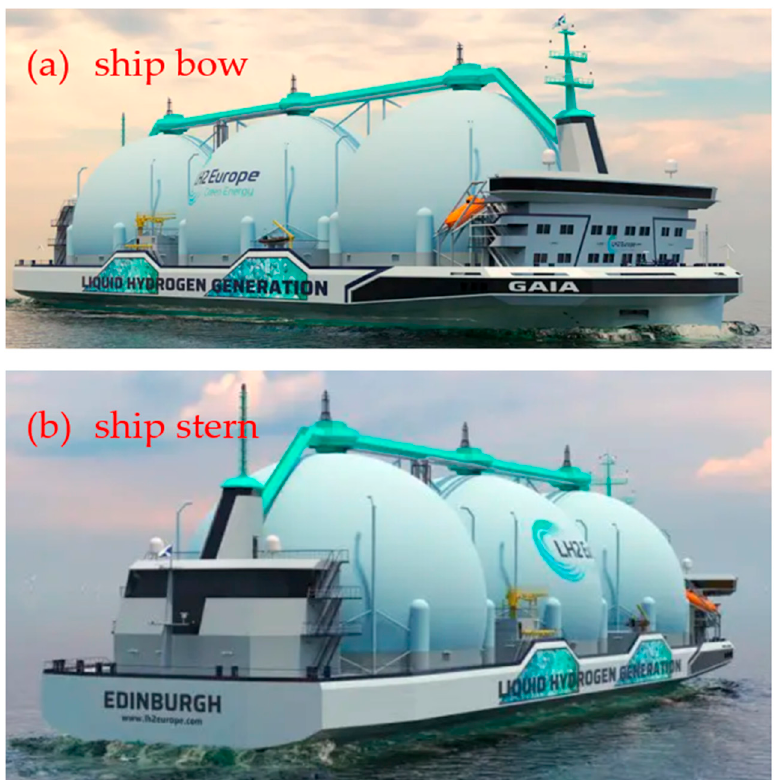
Figure 23. The conceptual design of the hydrogen carrier of C-Job Naval Architects [113].